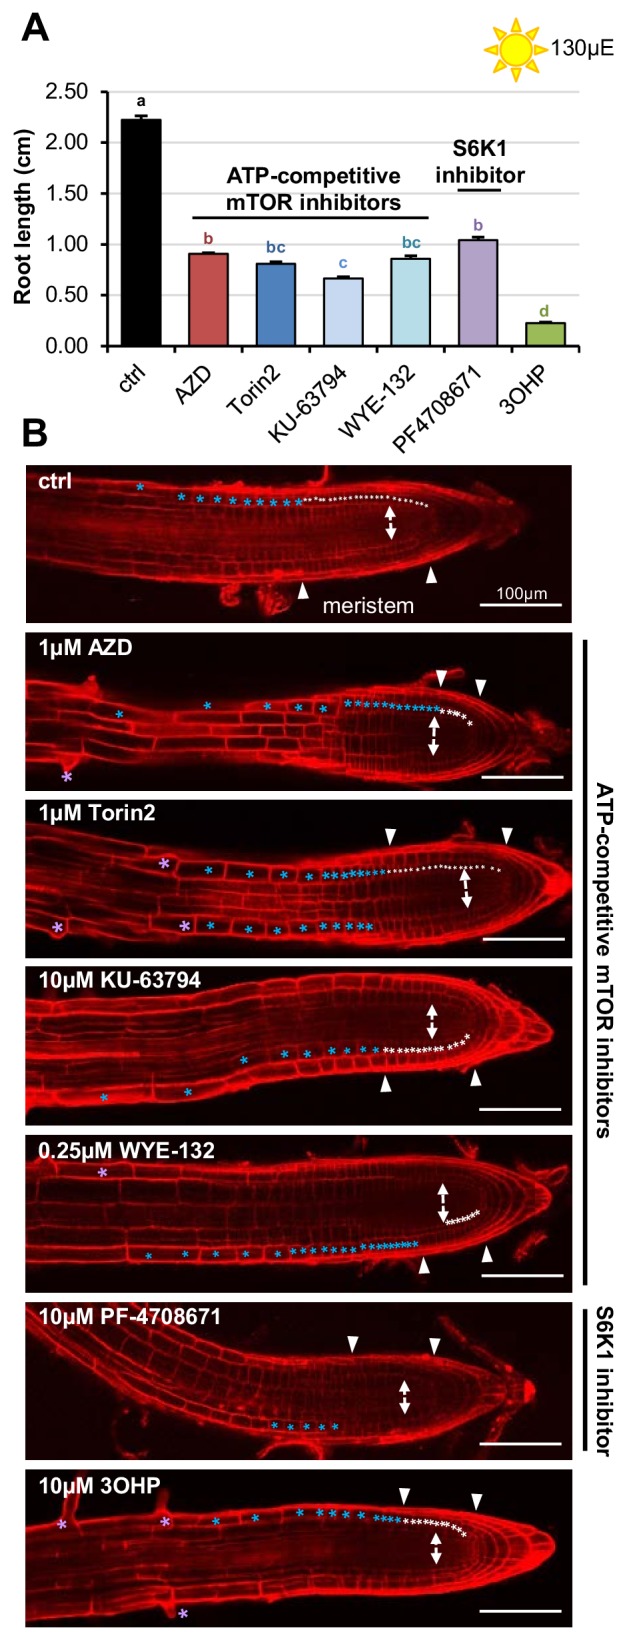
Pharmacological interactiosn between 3OHPGSL and diverse TOR inhibitors.(A) Root lengths of 7-d-old Col-0 wildtype seedlings grown on MS medium with sucrose ±the indicated mTOR or S6K inhibitors. Results are averages ± SE (n = 8–41). (B) Confocal images of 4–d-old propidium iodide stained seedlings. Meristemal cells are marked with white asterisks, elongated cells with blue, and cells belonging to the differentiation zone are marked with purple asterisks. Arrows indicate approximate meristem sizes.